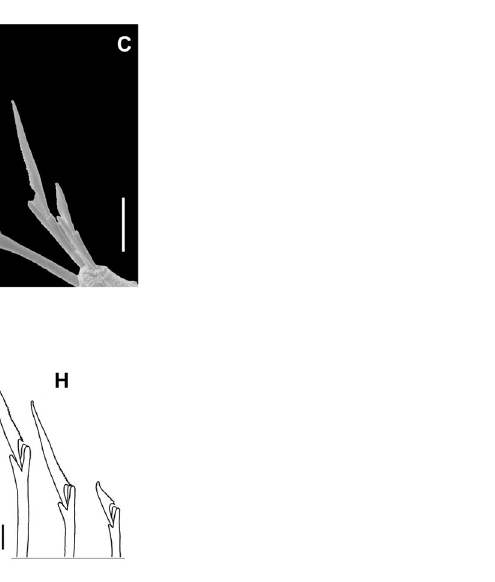
Fig 21. Meiodorvillea jumarsi sp. nov. (A,F) geniculate chaeta; (B,G) furcate chaeta; (C,H) compound chaetae; (D) cultriform chaeta; (E) capillary chaeta. Scale bars: (A,B,D) = 5 μ m; (C) = 10 μ m; (E) = 12.5 μ m; (F,G,H) = 6.25 μ m. https://doi.org/10.1371/journal.pone.0264081.g021 absent thereafter. Papilliform ventral cirrus in all parapodia, absent in the first one, inserted medially in the parapodium (Fig 20C and 20D), shorter than dorsal when both present. Supra-acicular chaetae: (1) one long and serrated capillary (Fig 21E); (2) one geniculate with serrated margin present in chaetigers 1 to 8 (Figs 18C, 21A and 21F), replaced by (3) one furcate with short and asymmetrical prongs in shape and size and serrated base (Fig 21B and 21G). Sub-acicular chaetae: (4) three compound heterogomphs (Fig 21C and 21H), dorsalmost longest with falcigerous or spinigerous blade and Y-shaped shaft (Fig 20B) in the first eight chaetigers, median falcigerous, ventralmost falcigerous and shortest; distal end of shafts ser- rated, blades unidentate and serrated cutting edge; (5) one cultriform with serrated margin replacing the ventralmost compound in last chaetigers (Fig 21D). All chaetae gradually slender and longer along body. One internal thick acicula (Fig 20B and 20D). Pygidium rounded and narrower than previous chaetigers. Two pairs of clavate pygidial cirri, dorsal pair twice as long as pygidium, ventral pair 1.5 times as long as pygidium (Figs 18D, 19C and 19D).